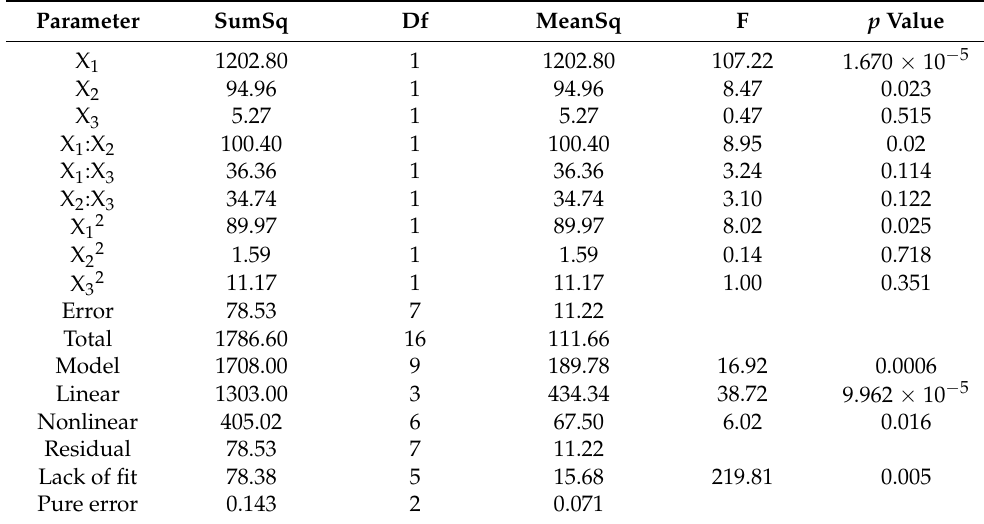
Table 3. ANOVA results for the full second-order polynomial